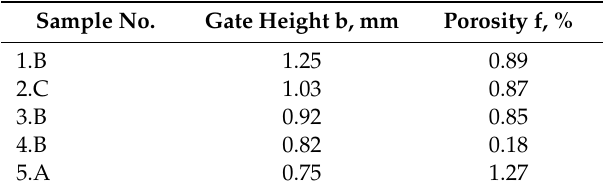
Table 6. Porosity values f.